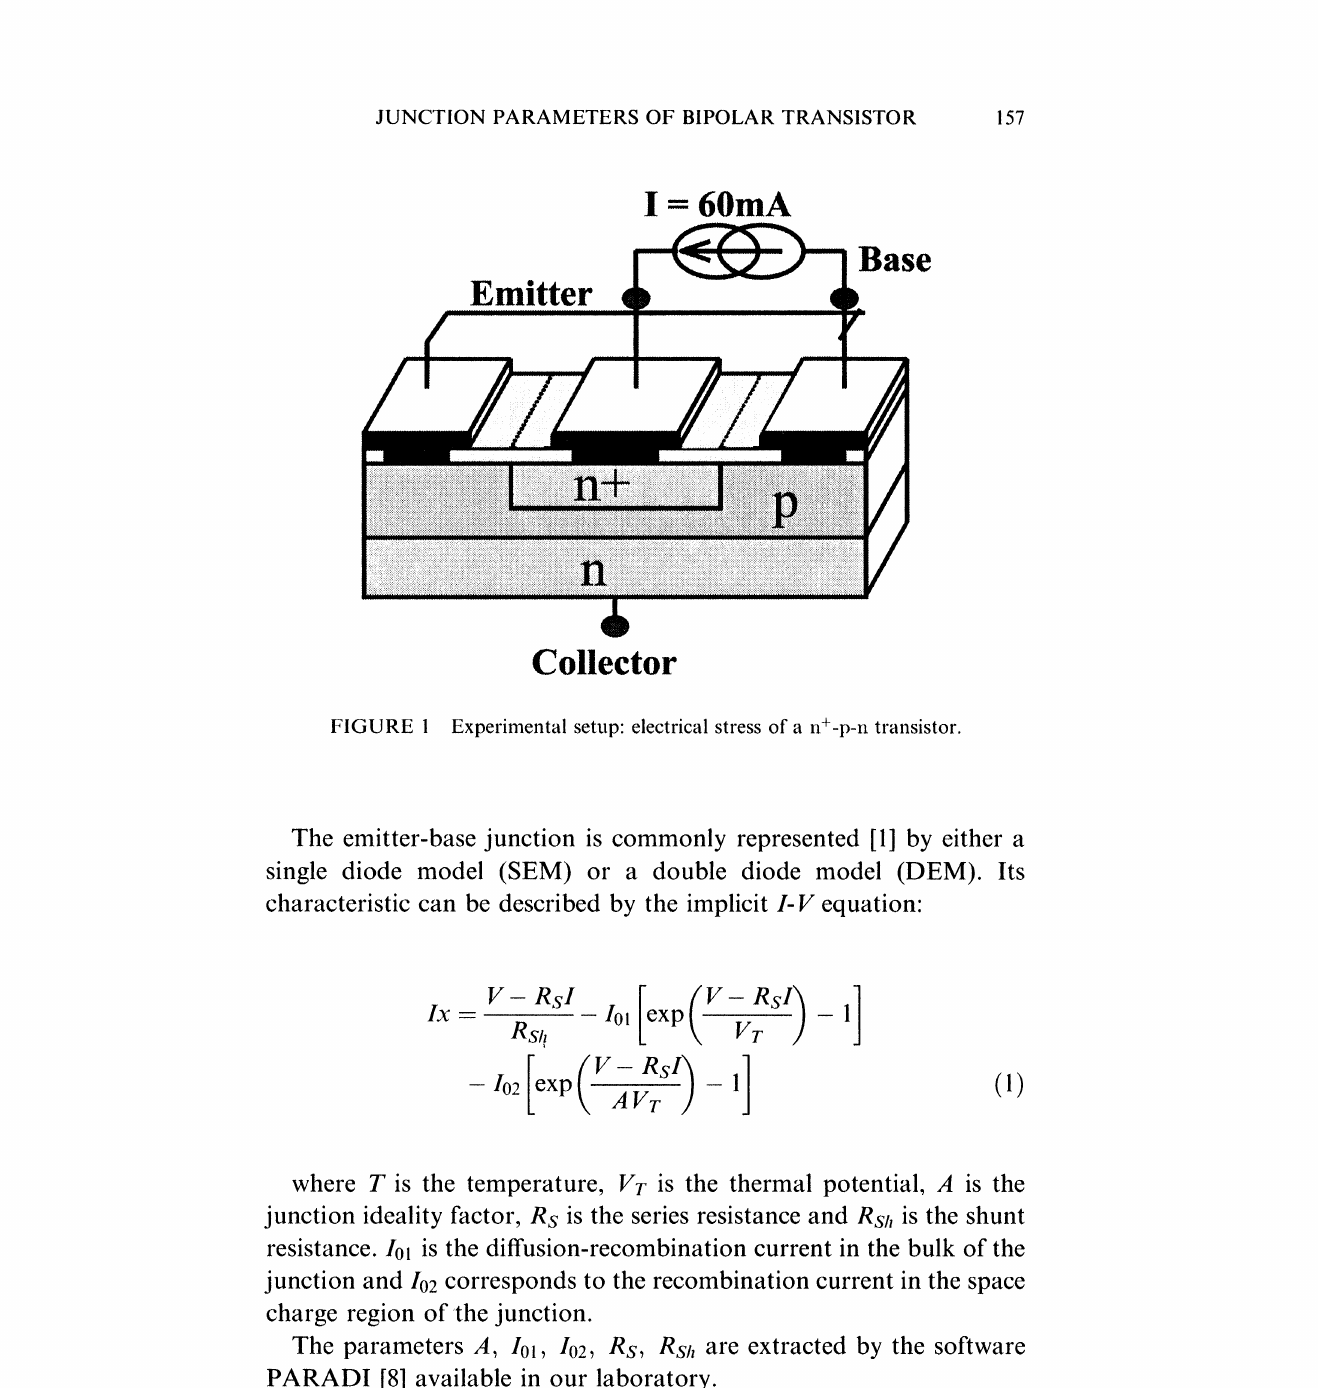
V Rs__I_iol Ix- exp -1 Rs: